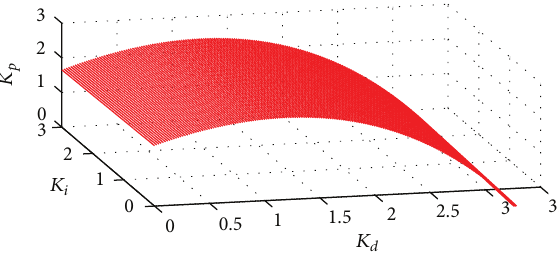
Figure 2: Bifurcation surface of 𝐾 𝑝 , 𝐾 𝑖 , 𝐾 𝑑 .